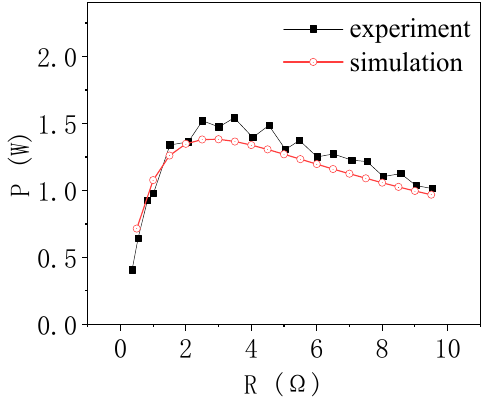
Figure 4. Output power varies with load resistance.